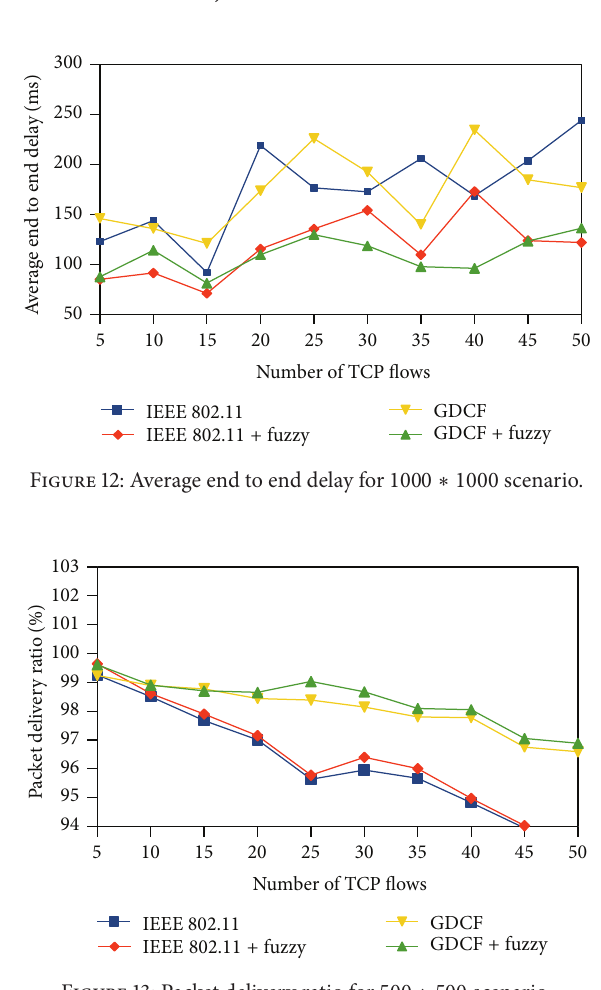
Figure 16: Number of RTS, CTS collisions for 500 ∗ 500